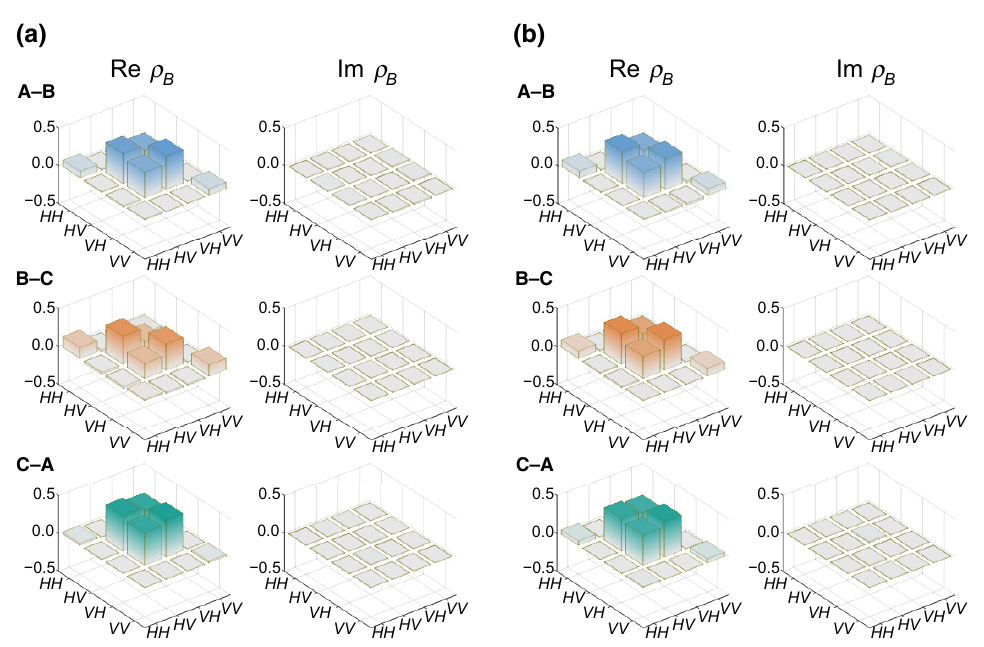
FIG. 5. Density matrices estimated by polarization tomography for each pair of users for (a) Allocation 1 and (b) Allocation